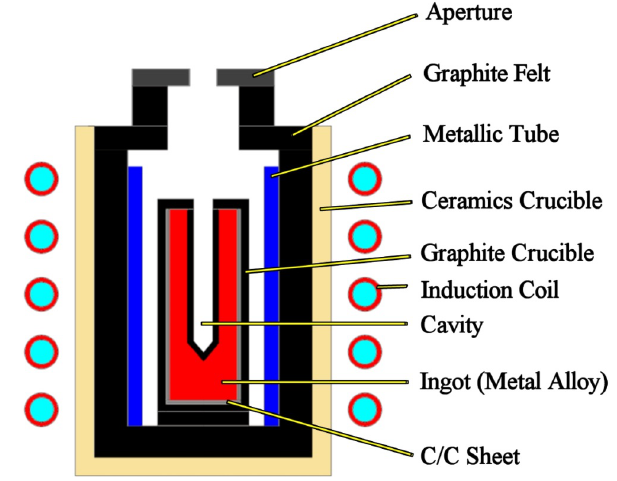
Figure 9. Schematic drawing of the setup for indirect induction heating of a fixed-point cell with a metallic tube as the heating ele- ment (outer diameter of ceramic crucible: 50mm).